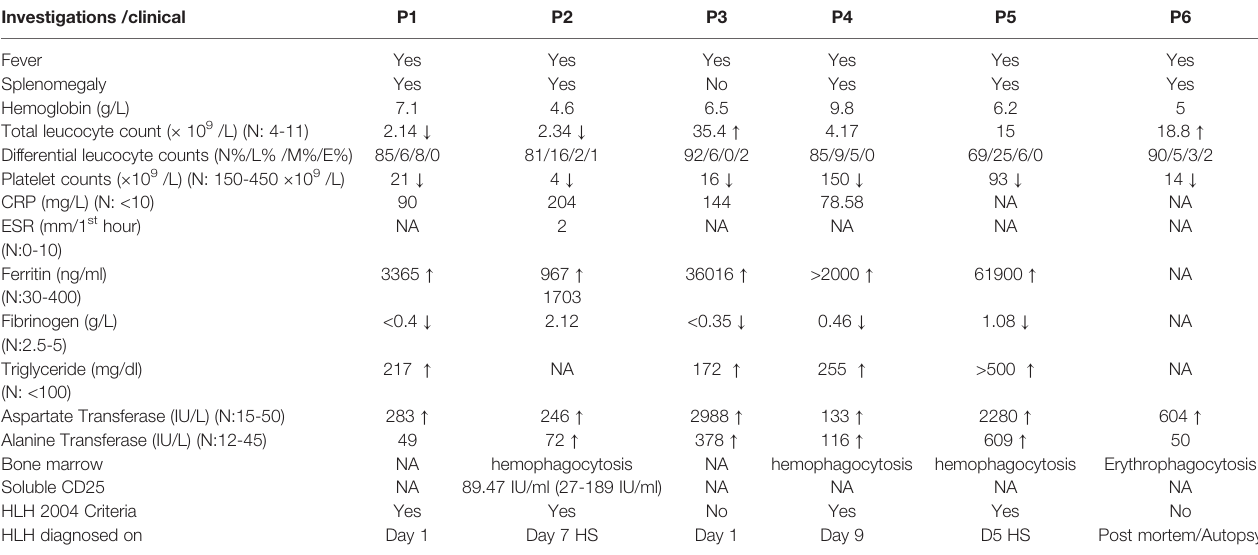
TABLE 1 | Clinical and laboratory features of HLH in patients with SCID from our cohort. Investigations